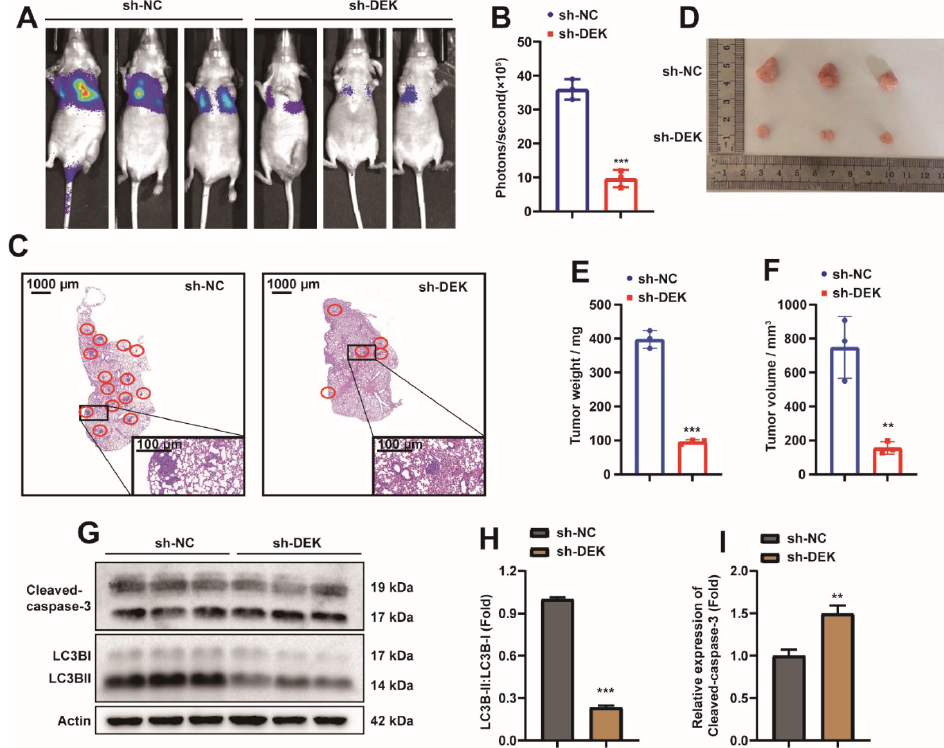
Figure 2. DEK accelerates the phenotype of GC. ( A ) Lung metastases were observed after luciferase- labeled DEK-knockdown (sh-DEK) or no-knockdown (sh-NC) SGC7901 cells were injected into nude mice via tail vein. ( B ) The luciferase bioluminescence values of mouse lung metastases ( n = 3). ( C ) HE staining analysis of lung metastasis in nude mice. ( D ) Xenografts were obtained by subcutaneous injection of DEK-knockdown (sh-DEK) or no-knockdown (sh-NC) SGC7901 cells. ( E , F ) The weight and volume of subcutaneous xenografts were counted and presented in the form of histograms (**: p < 0.01, ***: p < 0.001). ( G , H ) Western Blot analysis in subcutaneous xenograft tissue LC3B expression, results were normalized with Actin, and LC3BII/I ratios were analyzed. ( H , I ) Western Blot analysis of Cleaved-caspase-3 protein in subcutaneous xenograft tissue and nor- malized with Actin (**: p < 0.01, ***: p <